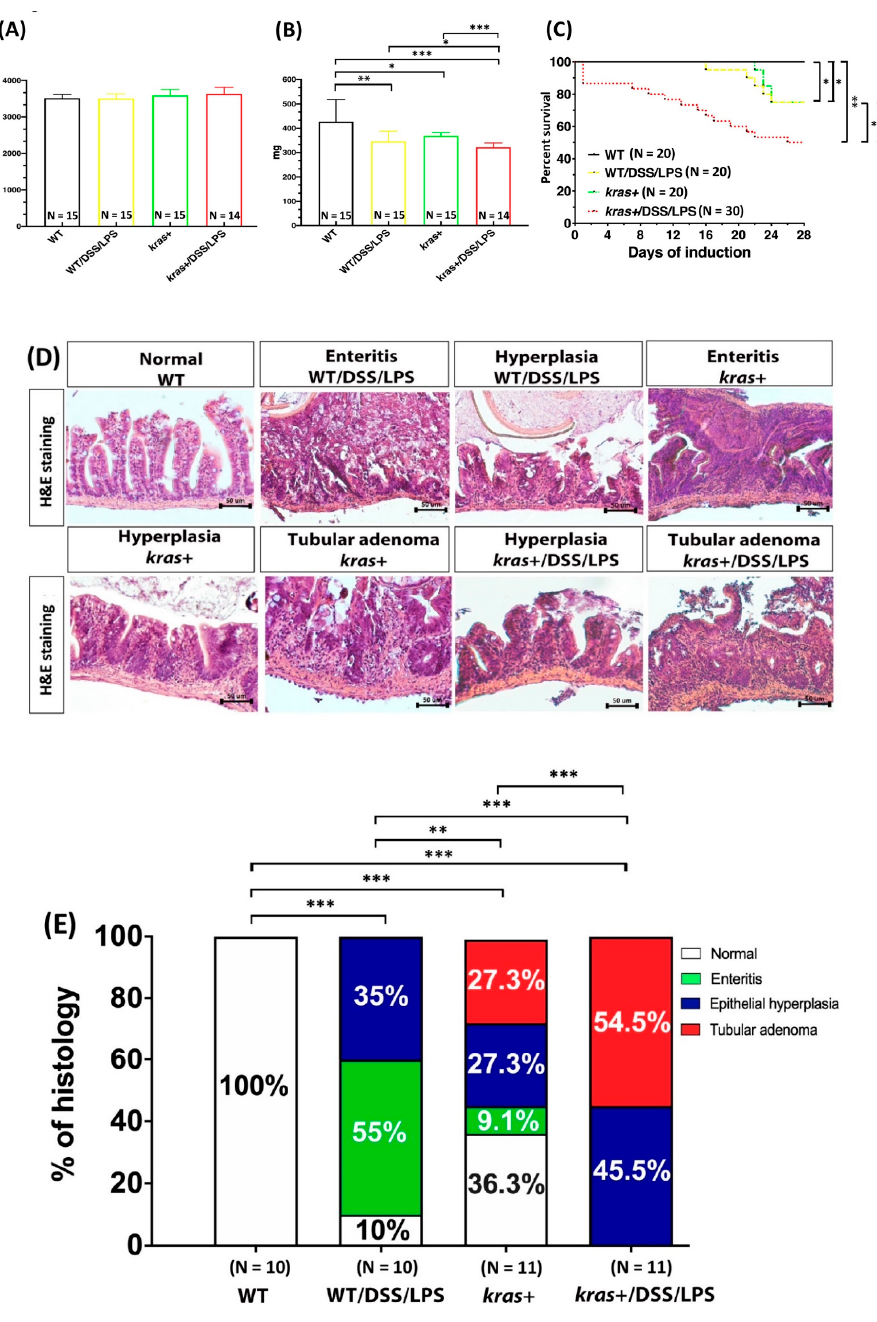
Figure 7. Synergistic effect of kras V 12 expression and LPS/DSS on intestinal tumorigenesis. Four-month-postfertilization wild-type and kras+ zebrafish were cotreated with 2 µ M of mifepristone, 40 ng/mL of LPS, and 0.0625% DSS for 4 weeks, and samples were then collected for gross observations and histological analyses. There were four experimental groups: WT, WT/DSS/LPS, kras+, and kras+/DSS/LPS. ( A , B ) Body length and body weight. ( C ) Survival curves. ( D ) Examples of normal intestines, enteritis, hyperplasia, and tubular adenoma as revealed by H&E staining of intestinal sections. ( E ) Sum- mary of intestinal histological abnormalities observed in the four experimental groups. These data were generated as a result of a blinded histological analysis (WT, n = 10; WT/DSS/LPS, n = 10; kras+, n = 11; kras+ with DSS/LPS, n = 11). Differences among the variables were assessed using Student’s t-tests or one-way ANOVA. Statistical significance: * p < 0.05, ** p < 0.01, *** p < 0.001. Scale bar: 50 μ m.